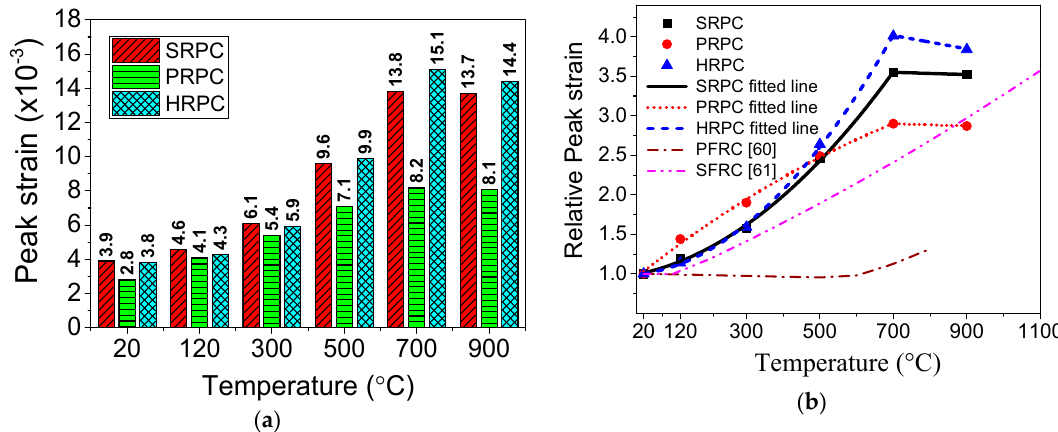
Figure 10. Peak strain of RPC: ( a ) absolute values and ( b ) normalized values.